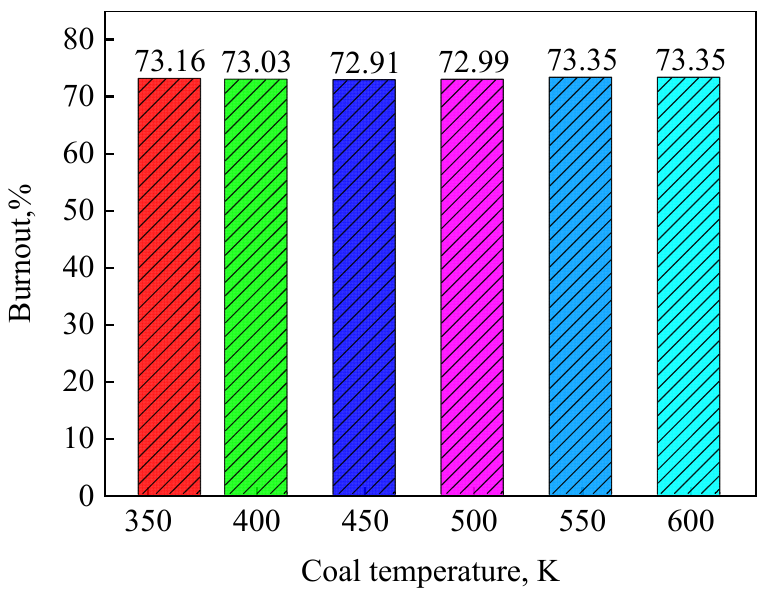
Figure 13. Effect of coal particles temperature on final coal burnout.